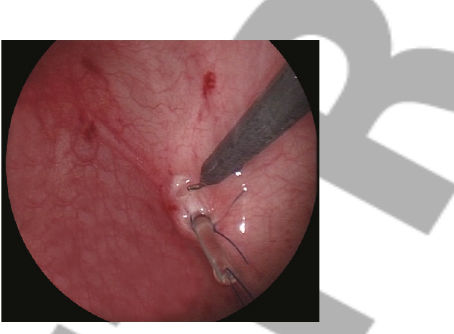
Figure 5: Once adequate ureteral length is obtained, the muscular defect in the ureteral hiatus is repaired using 5-zero absorbable sutures, usually with an extracorporeal knot-tying